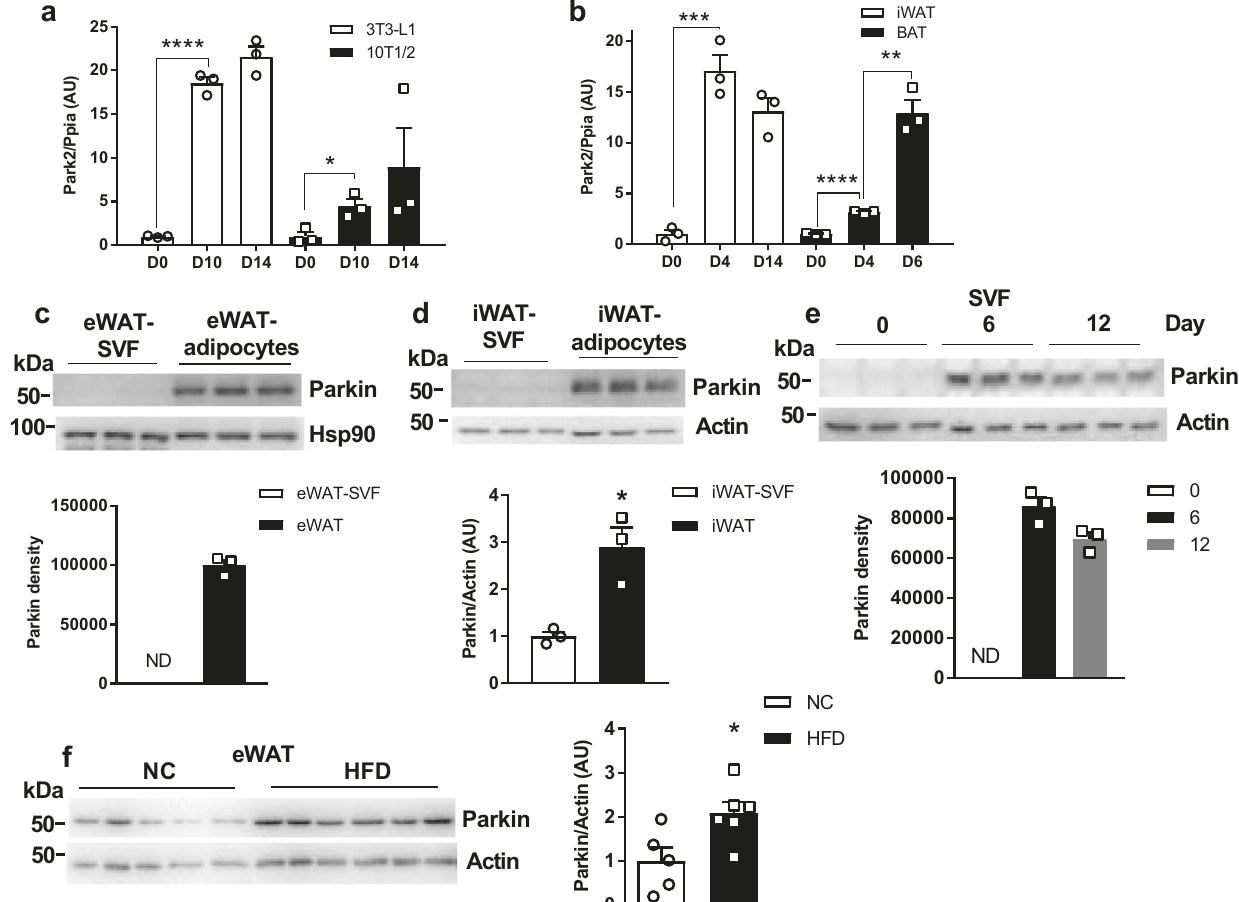
Fig. 1 | Parkin is elevated in white adipocytes during adipogenesis and by HFD feedingofmice.a , b mRNAlevelof Park2 duringdifferentiationof3T3-L1and10T1/ 2 adipocytes and primary adipocytes from iWAT and BAT of WT mice ( n =3 bio- logical replicate) [Unpaired Student ’ s t test two-tailed. For 3T3-L1 D0 vs. D10, p <0.0001, 95%CI=15.58 – 19.50, R squared=0.9936; for 10T1/2 D0 vs. D10 p =0.0207, 95%CI=0.8711 – 6.061, R squared=0.7747; for iWAT D0 vs. D4, p =0.0006,95%CI=11.56 – 20.54,Rsquared=0.9610,forBATD0vs.D4, p <0.0001, 95%CI=1.913 – 2.452, R squared=0.9922; for BAT D4 vs. D6, p =0.0015, 95% CI=6.284 – 13.26, R squared=0.9379.] Western blot analysis (top of panel) and correspondingdensitometricquanti fi cation(bottomofpanel;normalizedtoActin)